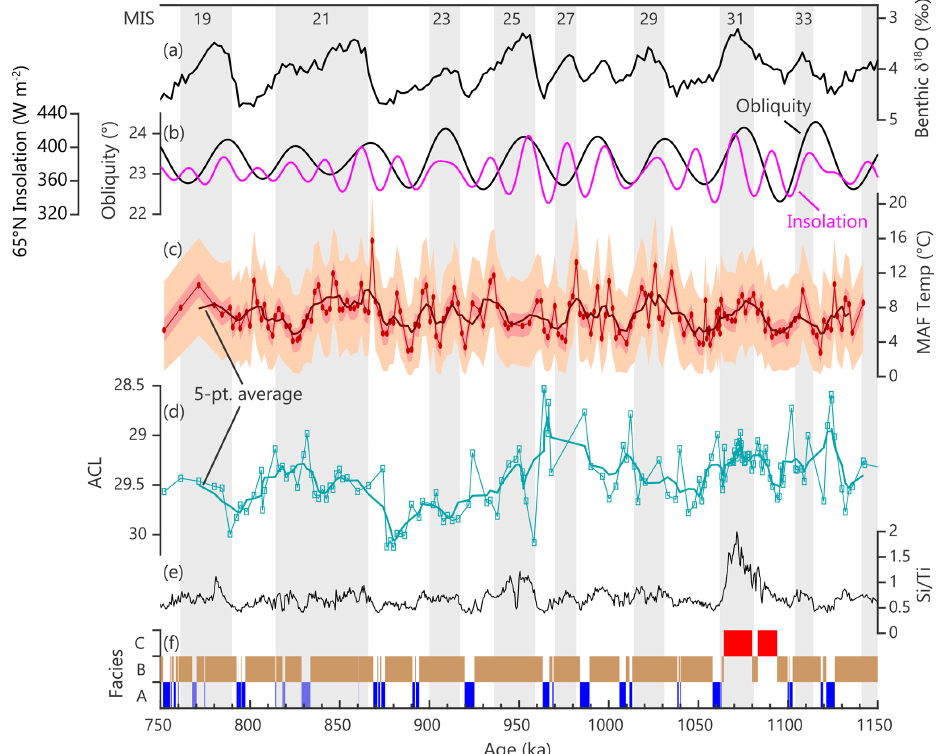
Figure 3. Lake El’gygytgyn data with Marine Isotope Stage (MIS) notated at the top and with interglacials indicated by the grey shading. (a) The global benthic oxygen isotope stack (Lisiecki and Raymo, 2005). (b) Astronomical forcing, including obliquity and summer insola- tion (21 June–21 September) at 65 ◦ N latitude (Laskar et al., 2004). (c) brGDGT-inferred temperature of the months above freezing (MAF analyses converted to temperature using BayMBT Temp). Dark shading represents the 1 σ analytical uncertainty based on triplicate MBT (cid:48) 5ME (1 σ = 1 . 35 ◦ C, n = 12), while light shading represents the calibration uncertainty (Martínez-Sosa et al., 2021). (d) n -alkane ACL based on C 27 –C 33 . (e) Lake El’gygytgyn silica (Si) to titanium (Ti) ratio (Melles et al., 2012; Wennrich et al., 2013). (f) Summary of lithological facies in core 5011-1. Facies A (blue bars) represents glacial intervals. Facies B (brown bars) is cosmopolitan, occurring during both glacials and interglacials. Facies C (red bars) represents superinterglacials.